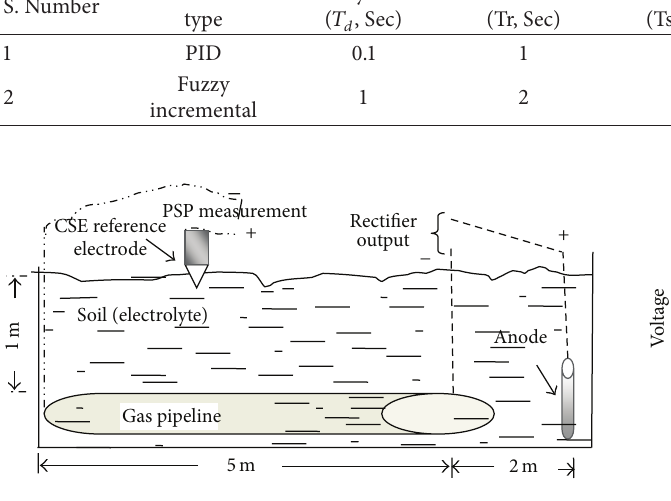
Figure 6: Experimental setup.